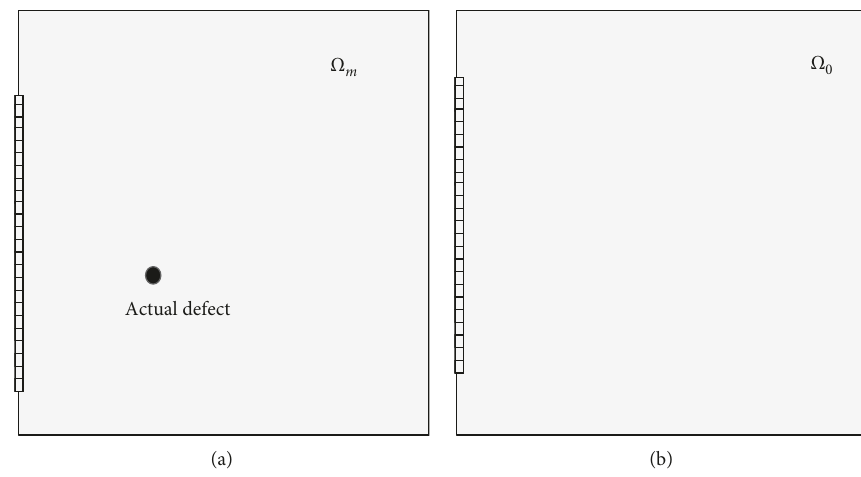
Figure 1: Top view of the test plate model: (a) reference test plate; (b) plate to be